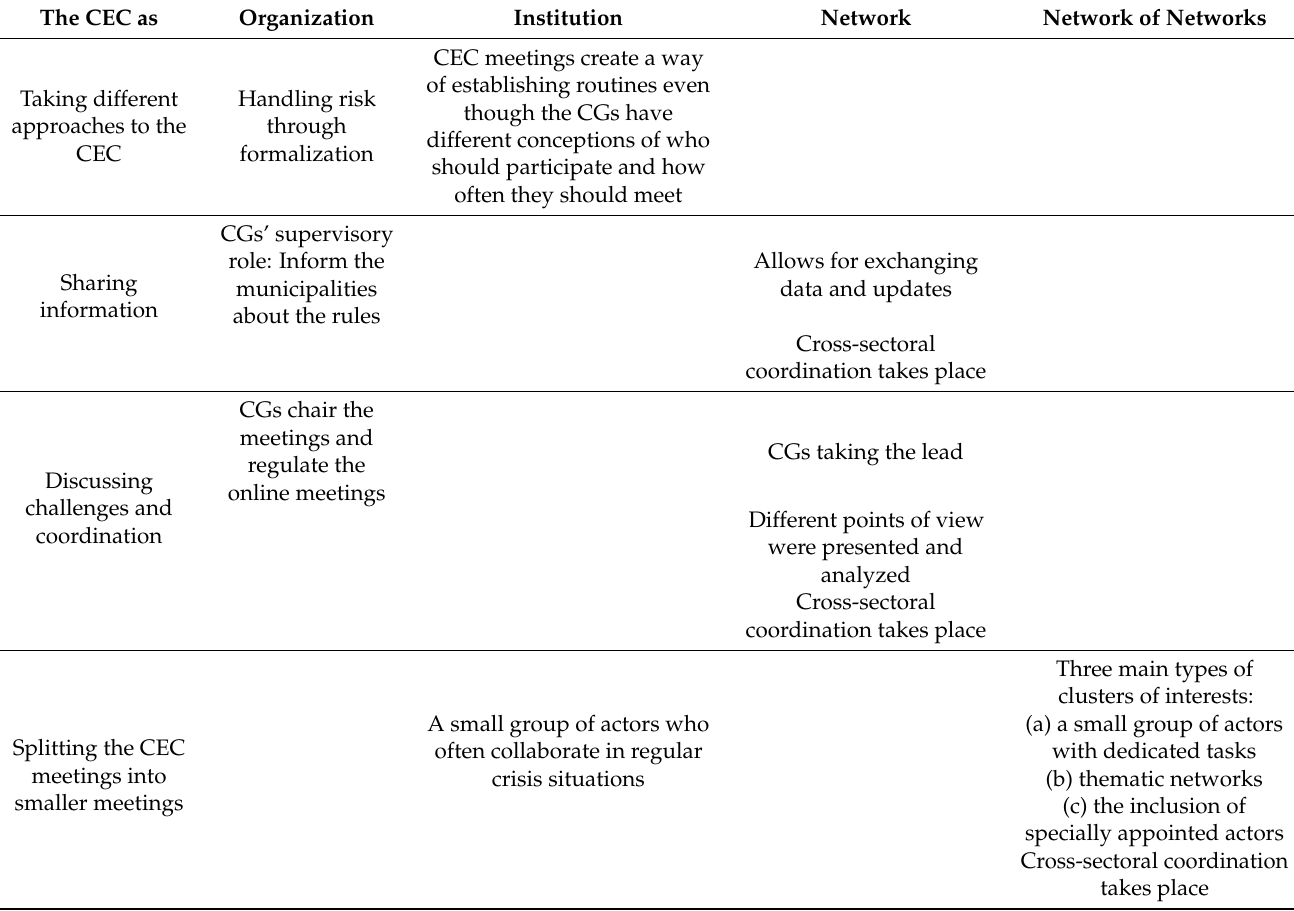
Table 2. Summary of results and